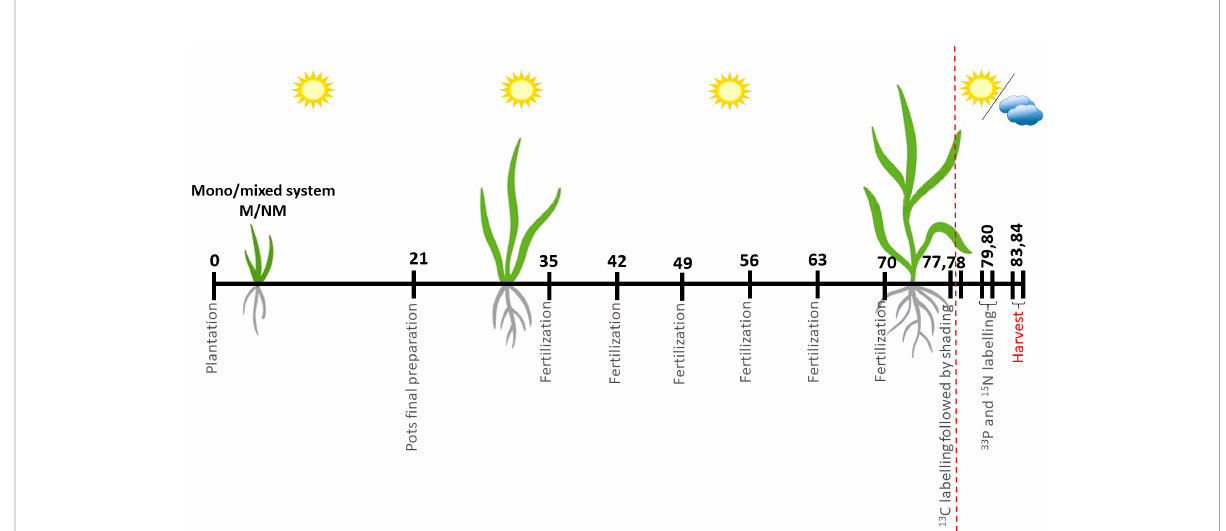
FIGURE 2 Timeline of the experiment. Final preparation of the pots was performed by plants thinned out to two individuals per pot (two individuals of the same species or one individual per pot of each plant species). Fertilization was carried out weekly by adding 65 ml of the Long-Ashton nutrient solution (containing only 20% of the original phosphorus concentration) per pot, until the 13 C labelling. 13 C and 33 P+ 15 N labelling was conducted on 77/78 and 79/80 days since plantation, respectively. Shading treatments were applied from day 77/78 onwards (the shading was initiated just after labeling the plants with 13 CO 2 ). Intervals not exactly to